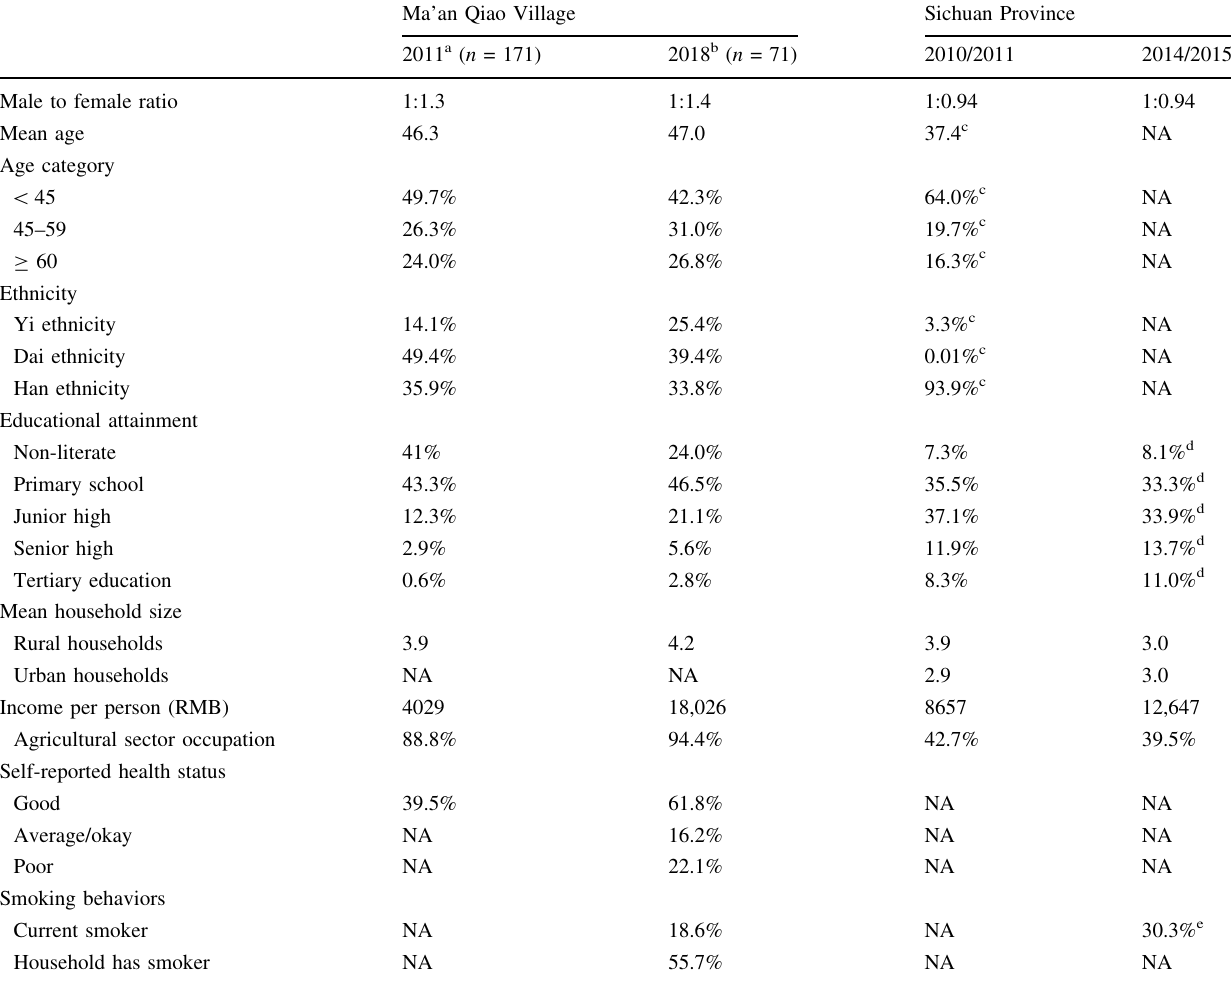
Table 1 Comparison of the sociodemographic characteristics of Ma’an Qiao Village and Sichuan Province between 2011 and